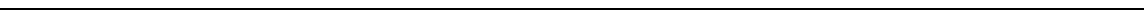
Figure 6 The retention of Pbl in the cytoplasm during mitotic exit prolongs myosin activity at the polar cortex. a Time-lapse images of pbl mutant cells expressing Pbl full length (Pbl-FL) or a Pbl NLS mutant (Pbl-NLSmut) expressed from the endogenous promoter. The cells carry normal chromosomes and express Sqh::GFP (Myo, gray ) and H2Az::mRFP (His, red ). The yellow bars correspond to the time of myosin ef fl ux in the Nb daughter cell. White arrowheads point to the position of ectopic myosin rings at the lateral regions of daughter cells. Time 0:00 corresponds to anaphase onset. See Supplementary Movie 5. b Kymographs of cortical myosin labeled with Sqh::GFP from one pole to the other over time for pbl mutant cells expressing Pbl-FL (one example) or Pbl-NLSmut (two examples) with NC. The fi rst example illustrates a cell undergoing myosin fl ashes at the polar cortex (as shown in c ). The second example shows a cell blebbing. The yellow and green bars show the duration of myosin cortical enrichment in Nb and GMC, respectively. The x and y axes of scale bars correspond to 2 min and 2 µ m, respectively. c Time-lapse images of Pbl-NLSmut cells with NC expressing Sqh::GFP well after anaphase onset. The top row represents a cell where myosin fl ashes at the polar cortex and the bottom row shows a cell blebbing. Yellow arrows indicate myosin fl ashes ( top panels ) and blebs ( bottom panels ). d Scatter dot plot showing the duration of myosin cortical enrichment in pbl mutant cells expressing Pbl-FL (NC, n = 29; TC, n = 33) or Pbl-NLSmut (NC, n = 87; TC, n = 26). e Scatter dot plot showing the elongation index in pbl mutant cells expressing Pbl-FL or Pbl-NLSmut with NC or TC. The DIC images of cells expressing or not H2Az::mRFP ( red ) above the graph provides a representative example of each genotype at the time of elongation index measurement. A signi fi cant proportion of cells expressing Pbl-NLSmut elongates in the absence of trailing chromatids. f Frequency of blebs in pbl mutant cells expressing Pbl-FL or Pbl-NLSmut with NC or TC. Time = min:s. n = number of cells. Scale bars = 5 µ m. The mean ± 95% CI is presented for all scatter dot plots and graphs. A Mann-Whitney test was used to calculate P values (**** corresponds to P <